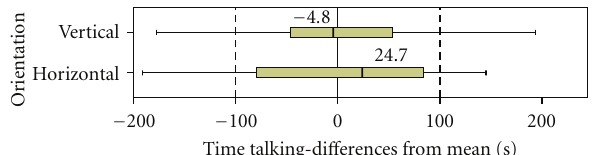
Figure 5: Equivalence of talking times, shown as di ff erences from the mean.